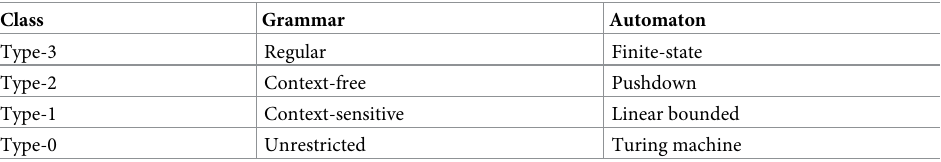
Table 1. The hierarchy of formal languages and corresponding